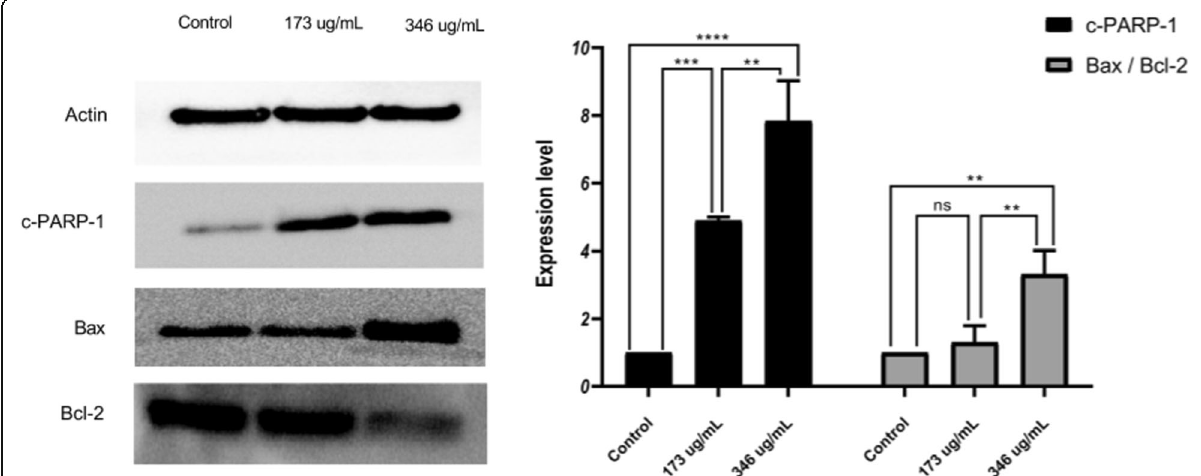
Fig. 5 The effect of AELE on the expression of pro- and anti-apoptotic proteins. Western blot analysis and quantification of apoptosis-regulating proteins in Monomac-1 cells treated with AELE for 24 h. Significant upregulation of cleaved PARP-1, and Bax/Bcl-2 ratio was observed between Monomac-1 control cells and cells treated with 173 μ g/ml or 346 μ g/ml of AELE for 24 h. Representative blots from three different experiments were cropped and are shown in the figure. The full-length blots are reported in the Additional file 1. (** indicates a p-value: 0.001 < p < 0.01, *** indicates a p-value: 0.0001 < p < 0.001 and **** indicates a p -value: p < 0.0001)